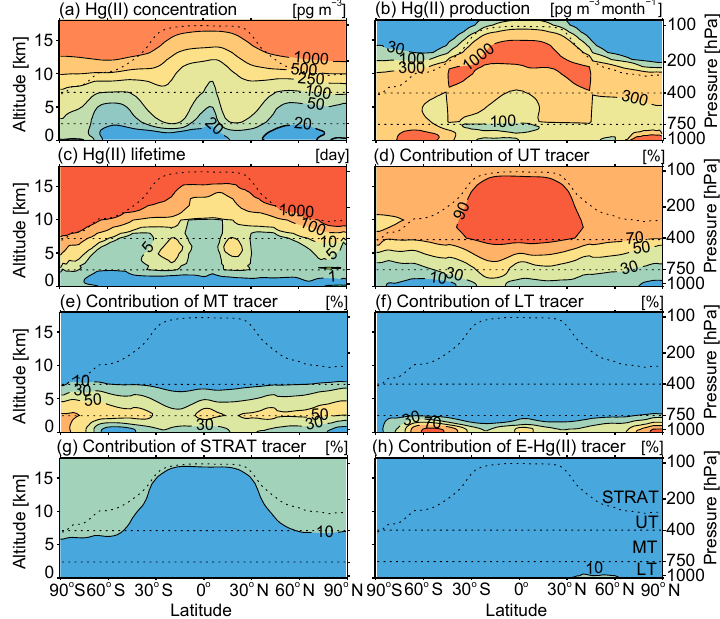
Figure 4. Modeled zonal mean (a) Hg(II) concentrations (pgm − 3 ), (b) Hg(II) production rates (pgm − 3 month − 1 ), and (c) lifetime (days) for 2013–2014. Panels ( d–h ) show the percent contributions of Hg(II) tagged tracers produced in the upper troposphere (UT), middle troposphere (MT), lower troposphere (LT), stratosphere (STRAT), and directly emitted (E-Hg(II)). Dotted lines indicate our boundaries for STRAT, UT, MT, and